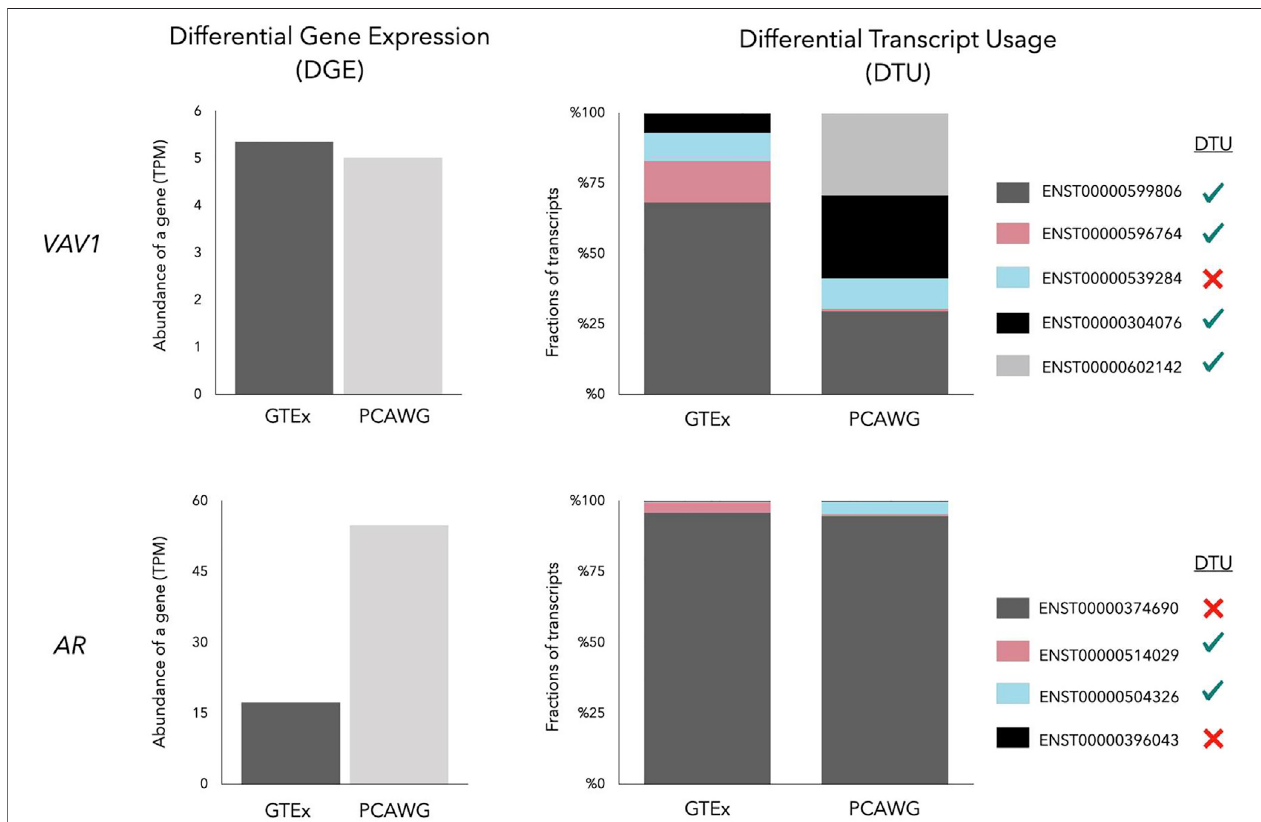
FIGURE 2 | Gene Expression of VAV1 and AR in a prostate normal tissue (GTEx) and a prostate cancer (PCAWG) sample. While the VAV1 gene has a similar total expression, the AR gene is overexpressed in prostate cancer showing Differential Gene Expression (DGE). Despite the similar total gene expression, four of fi ve transcripts of VAV1 undergo Differential Transcript Usage (DTU) between normal and prostate cancer, symbolized by four green ticks and one red cross in the legend. The major transcript of AR (dark grey bar) remains highly expressed in prostate cancer, but minor transcripts, including AR-V7 (blue bar), are subjected to